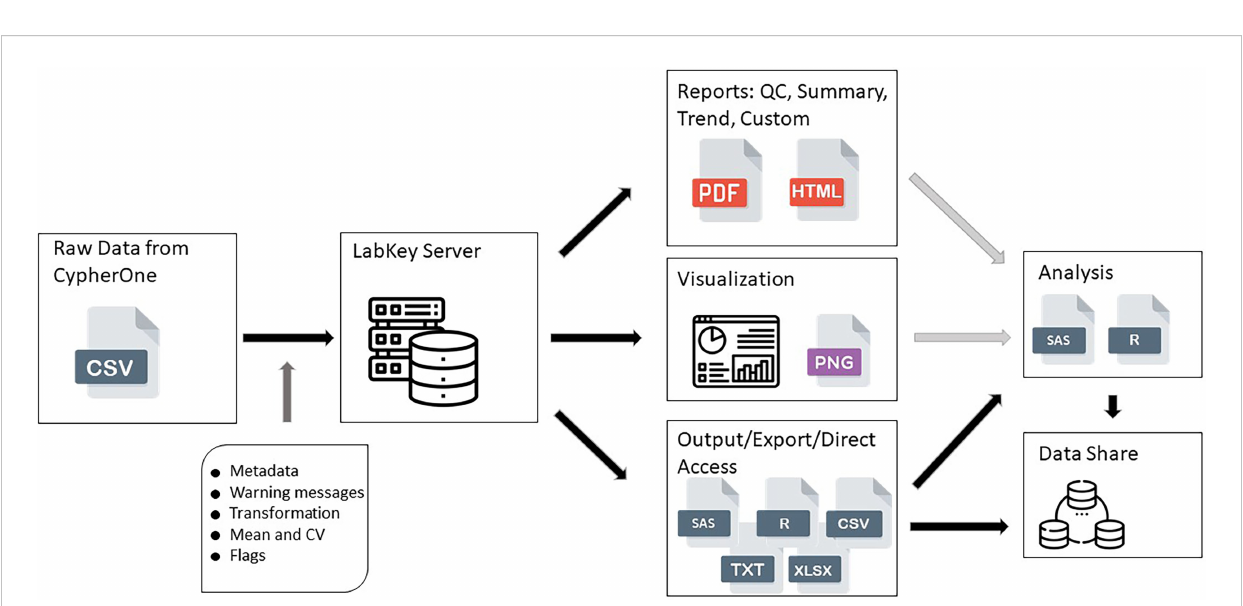
FIGURE 1 HAI assay design data pipeline. This fi gure shows the data fl ow from raw data generated by CypherOne Software to processed data used for analysis and data sharing. Light grey arrows indicate decision making steps: generated reports and visualization assists with determining the quality of the data and analysis readiness. Dark grey arrow indicates main processing steps performed during data upload. Black arrows indicate data pipeline steps which are scripted and